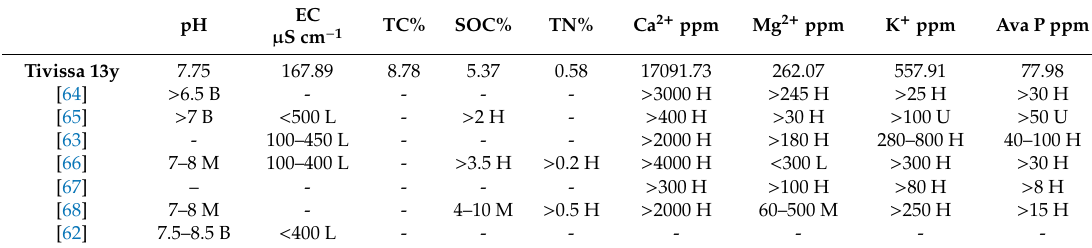
Table 3. Mean chemical property values recorded at the Tivissa (TVA) plot on the last sampling date (13 years after first PF) compared with values reported in soil reports for the area. B, Basic; H, High; M, Medium; L, Low; U, Above